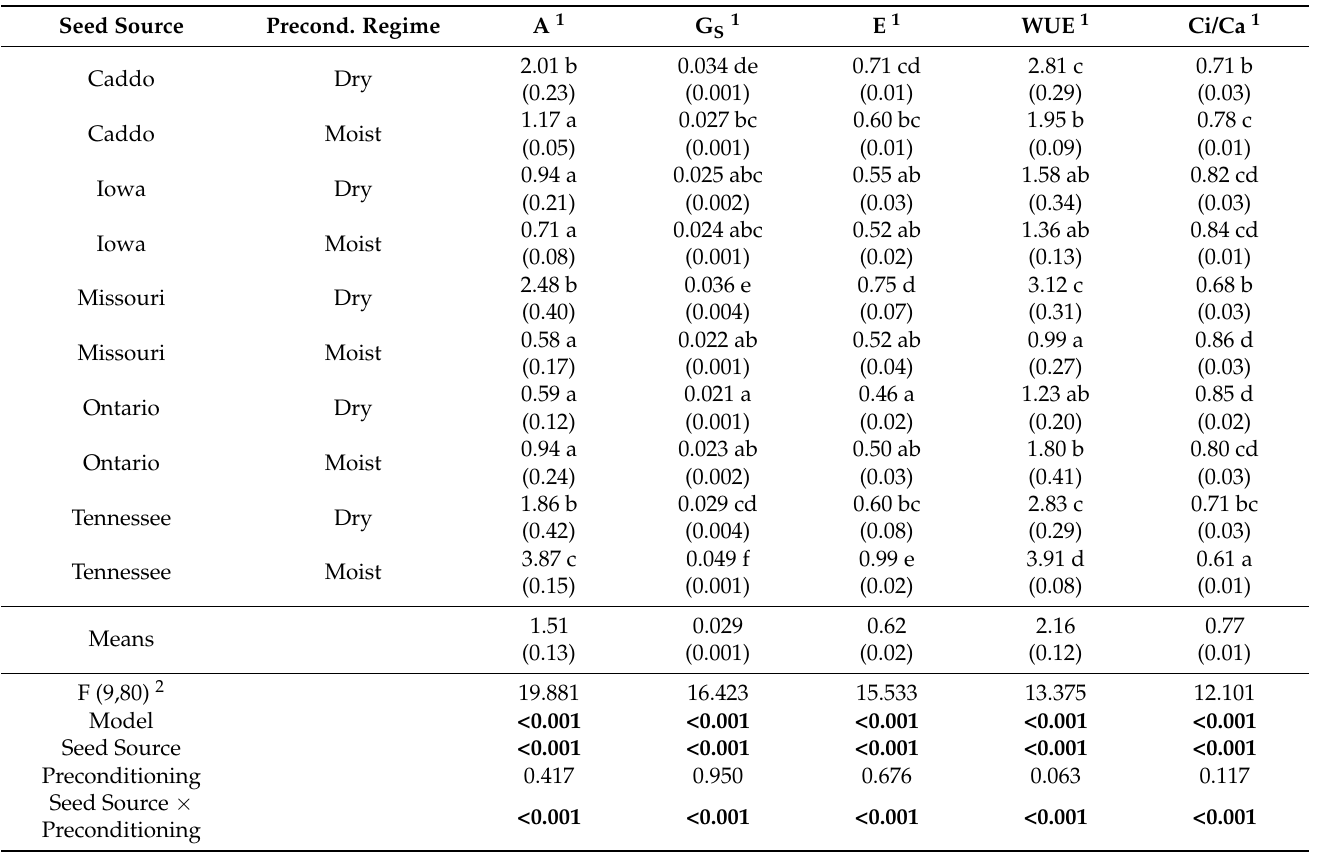
Table 5. Net photosynthesis (A, µ mol CO 2 m − 2 s − 1 ), leaf conductance to water vapor (G S, mol H 2 O m − 2 s − 1 ), transpiration